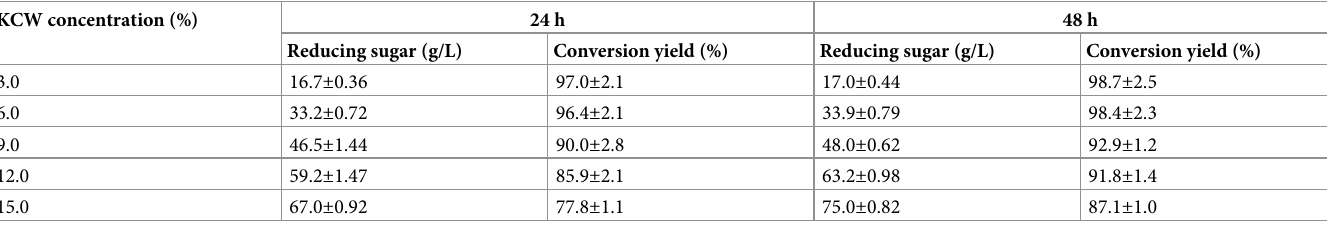
Values represent the average of three